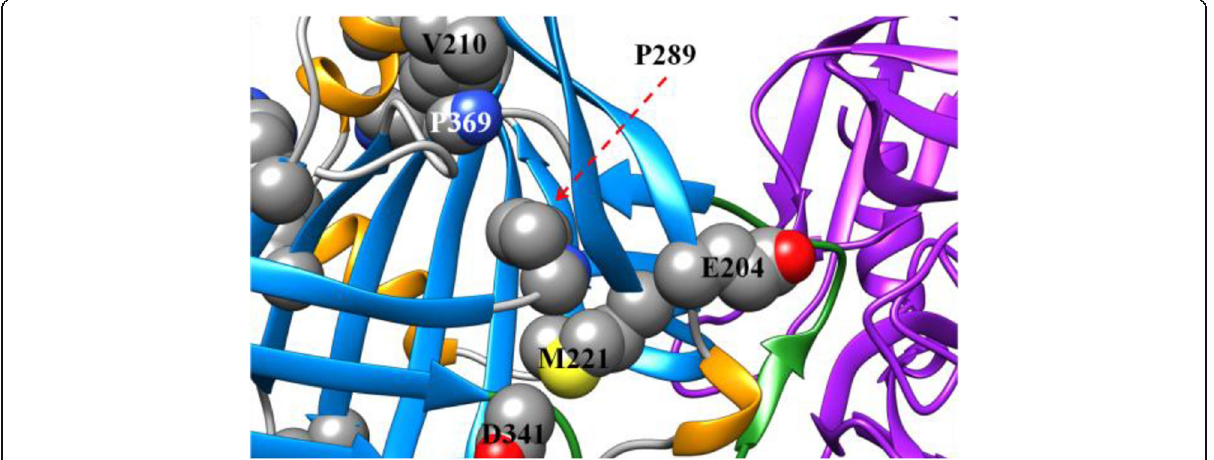
Fig. 3 Structure of AAT zoomed in on locations of interest. Presented are some of the missense residues predicted to negatively affect the stability of the folded protein. Several of these missense changes are in the tightly packed core of the protein, such as the P289S variant packed tightly near the M221T variant